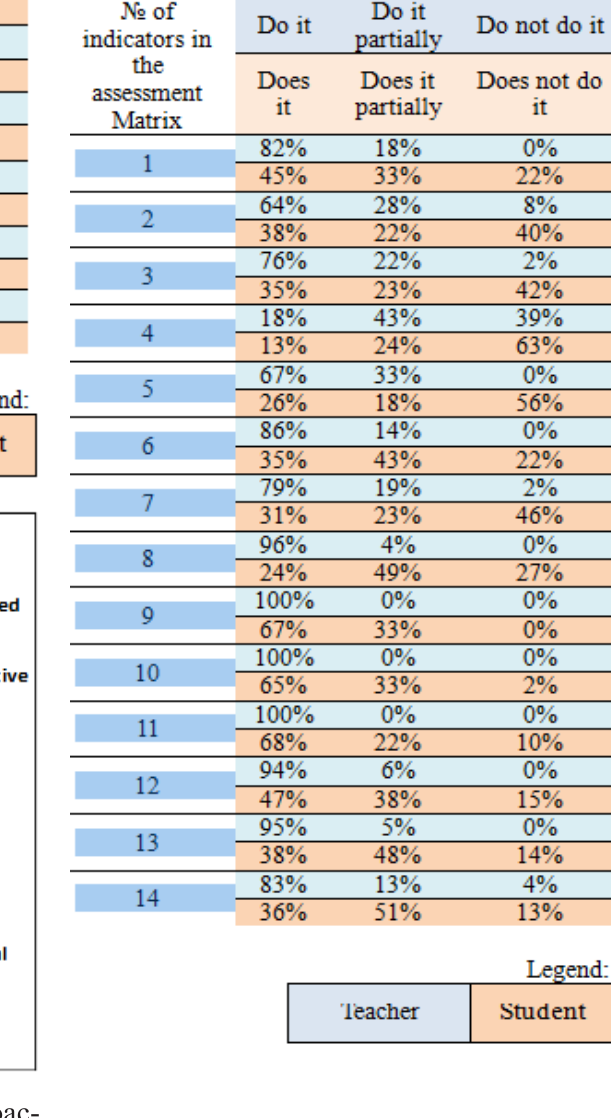
Table 5. Results. Factor